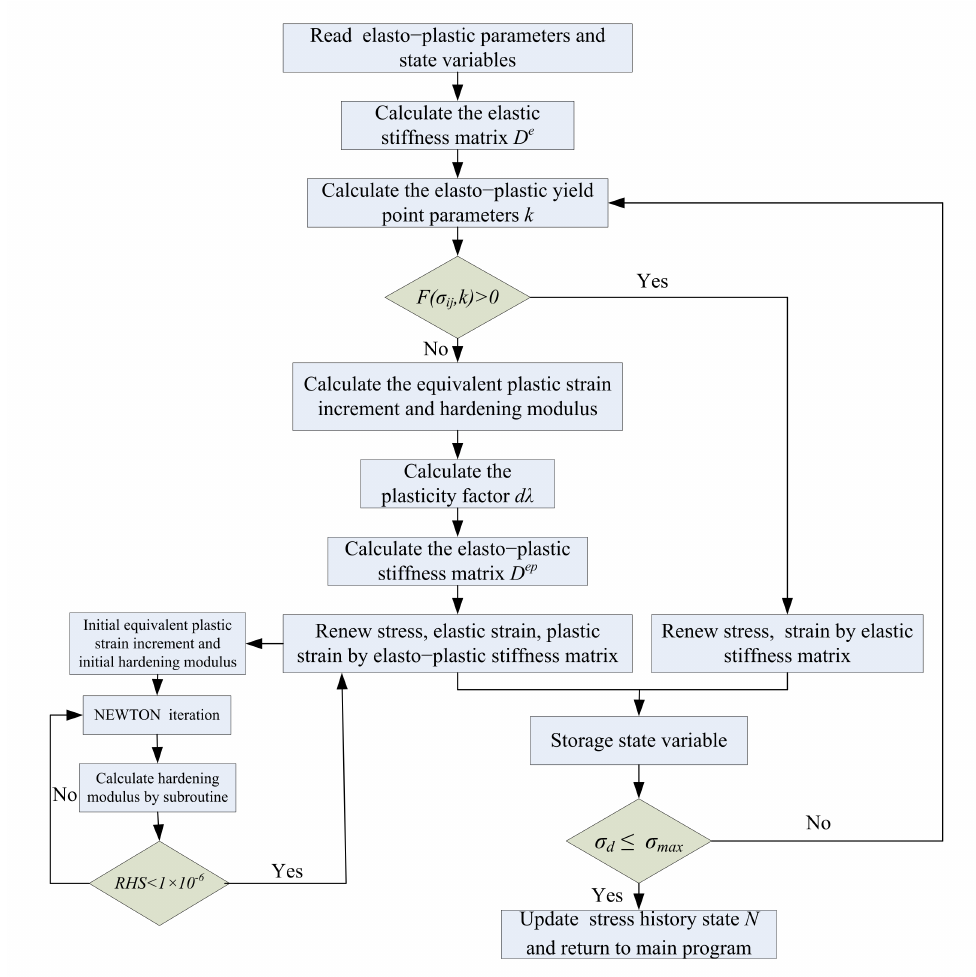
Figure 2. Flowchart of the UMAT